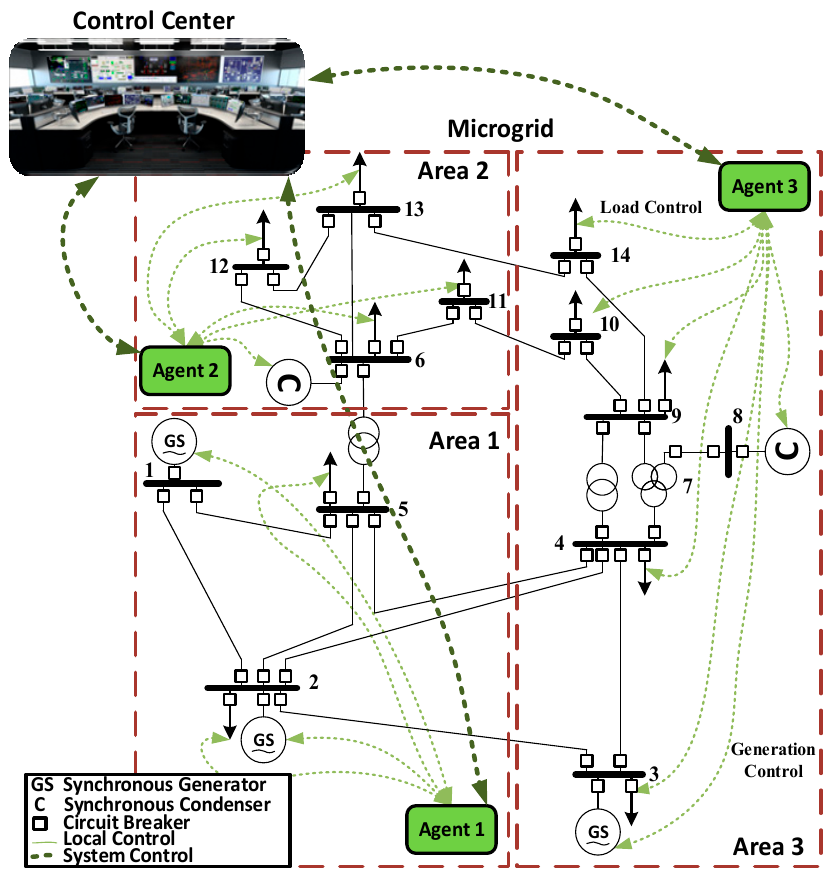
Figure 1. 14-Bus IEEE benchmark system with decentralized and hierarchical control.